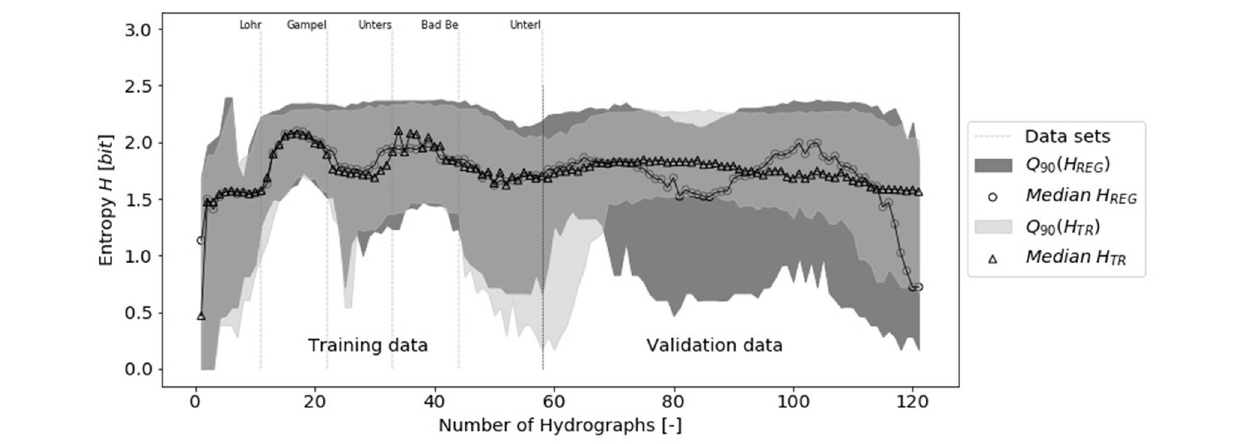
FIGURE 11 | Development of entropy H for merged training and validation (regional REG /trans-regional TR ) data sets. Median (black lines) and 90%-uncertainty belts calculated by randomly adding 50% of the available hydrographs per sub-basin to the merged data